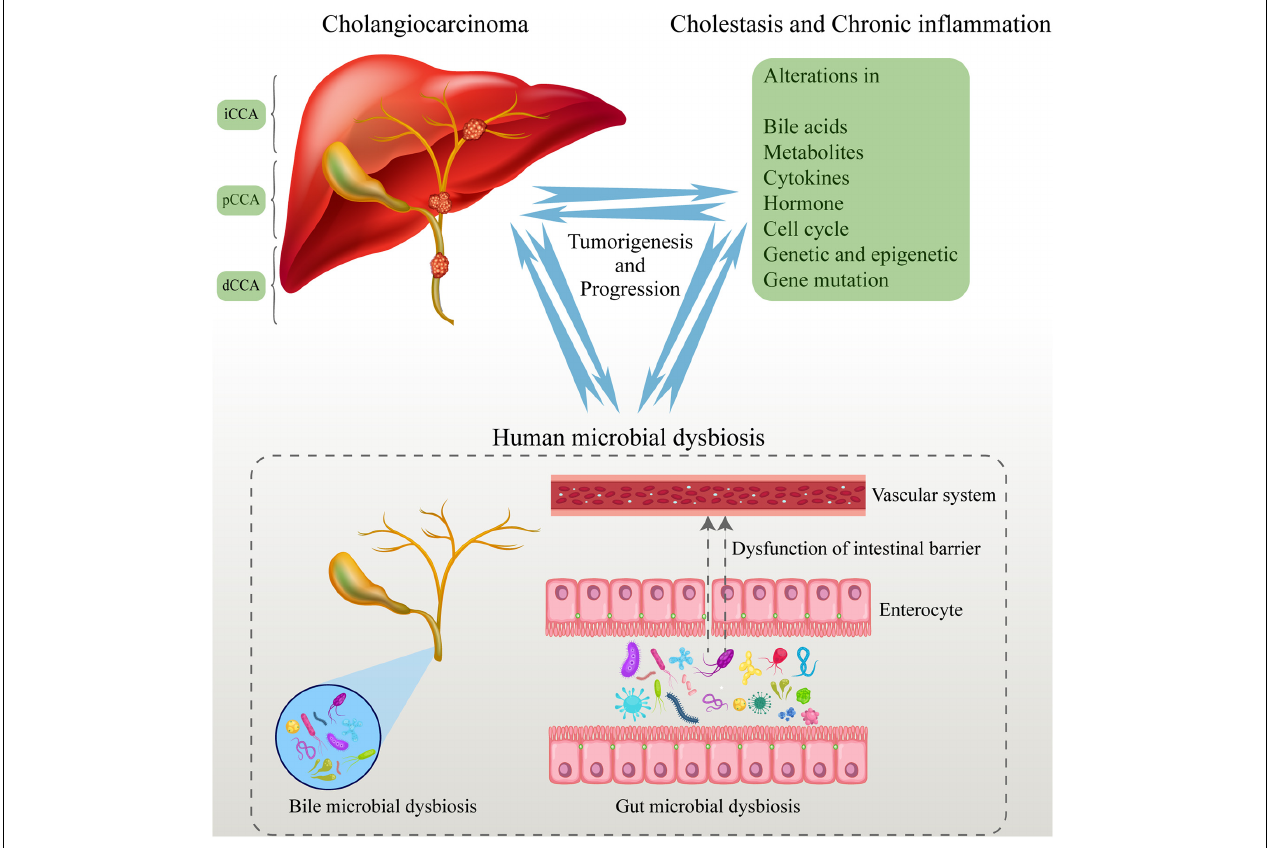
FIGURE 1 | Human microbial dysbiosis promotes the tumorigenesis and progression of CCA. The human microbiome dysbiosis occurred in the process of CCA tumorigenesis. The entry of abnormal microbiome and their metabolites into the blood promotes the progression of CCA. At the same time, CCA aggravates the dysbiosis of the human microbiome by many ways, leading to a vicious circle. CCA,